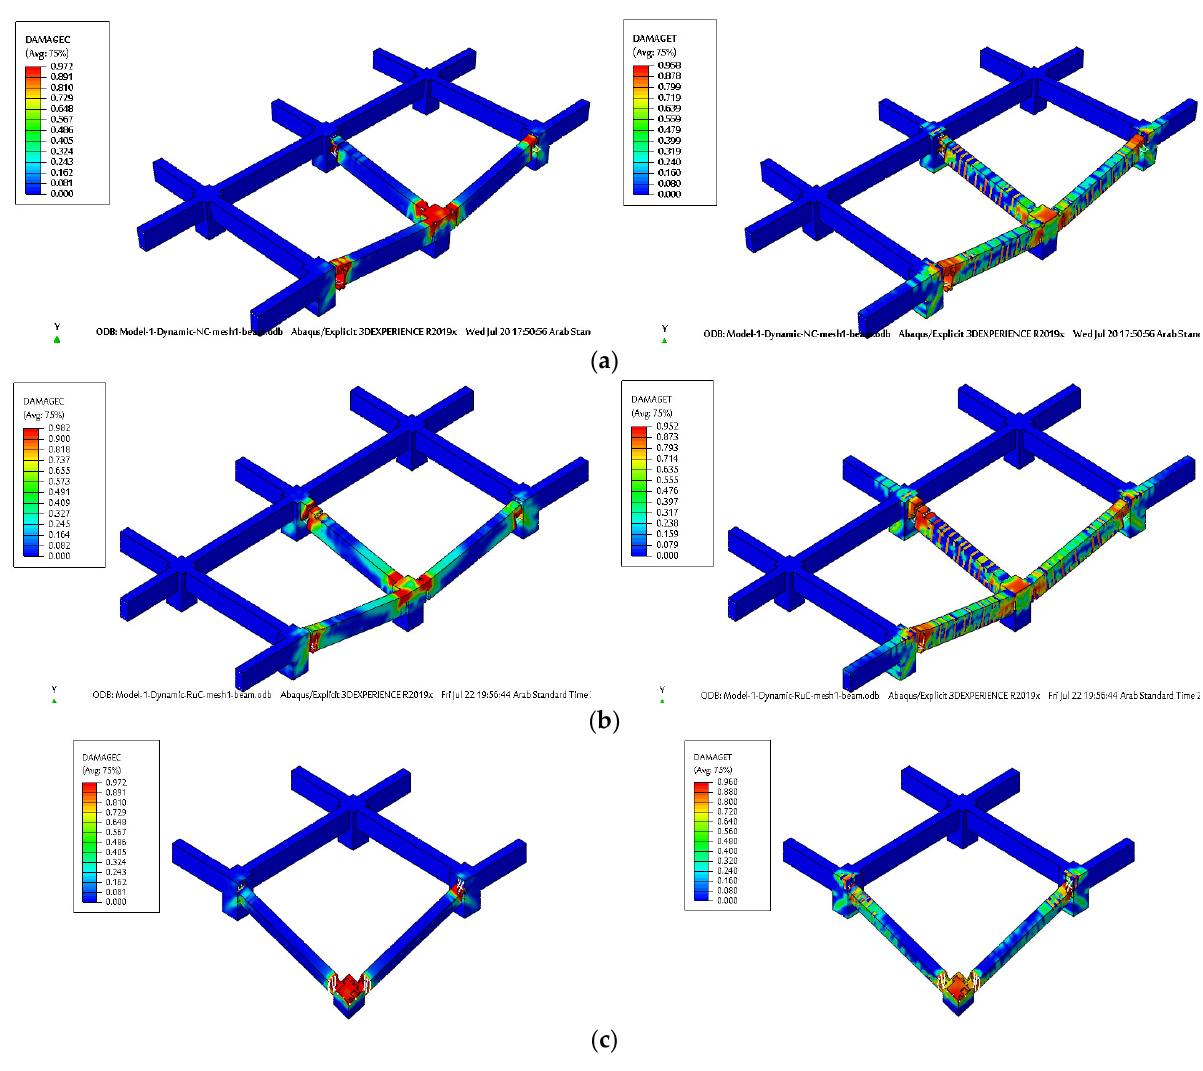
Figure 20. Horizontal reaction force–displacement curves: ( a ) Scenario “A” specimens and ( b ) Sce- nario “B” specimens.